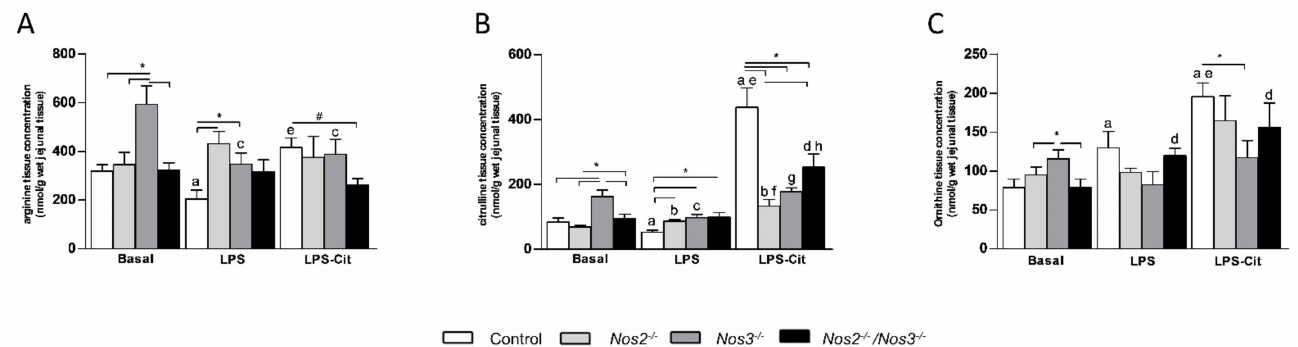
Figure 2. Jejunal arginine, citrulline and ornithine concentrations in control and Nos -deficient mice under basal and endotoxemic conditions with or without L-citrulline supplementation. ( A ) Jejunal arginine concentrations in control and Nos -deficient mice under basal and endotoxemic conditions with or without L-citrulline supplementation. ( B ) Jejunal citrulline concentrations in control and Nos -deficient mice under basal and endotoxemic conditions with or without L-citrulline supplementation. ( C ) Jejunal ornithine concentrations in control and Nos -deficient mice under basal and endotoxemic conditions with or without L-citrulline supplementation.* p -value < 0.05; # p -value < 0.01; a p -value < 0.05 vs. control mice under basal conditions; b p -value < 0.05 vs. Nos2 − / − mice under basal conditions; c p -value < 0.05 vs. Nos3 − / − mice under basal conditions; d p -value < 0.05 vs. Nos2 − / − /Nos3 − / − mice under basal conditions; e p -value < 0.05 vs. control + LPS; f p -value < 0.05 vs. Nos2 − / − mice + LPS; g p -value < 0.05 vs. Nos3 − / − mice + LPS; h p -value < 0.05 vs. Nos2 − / − /Nos3 − / − mice + LPS. Data are shown as mean ± SEM. Statistical significance was determined with one-way ANOVA and post-hoc Bonferroni correction between